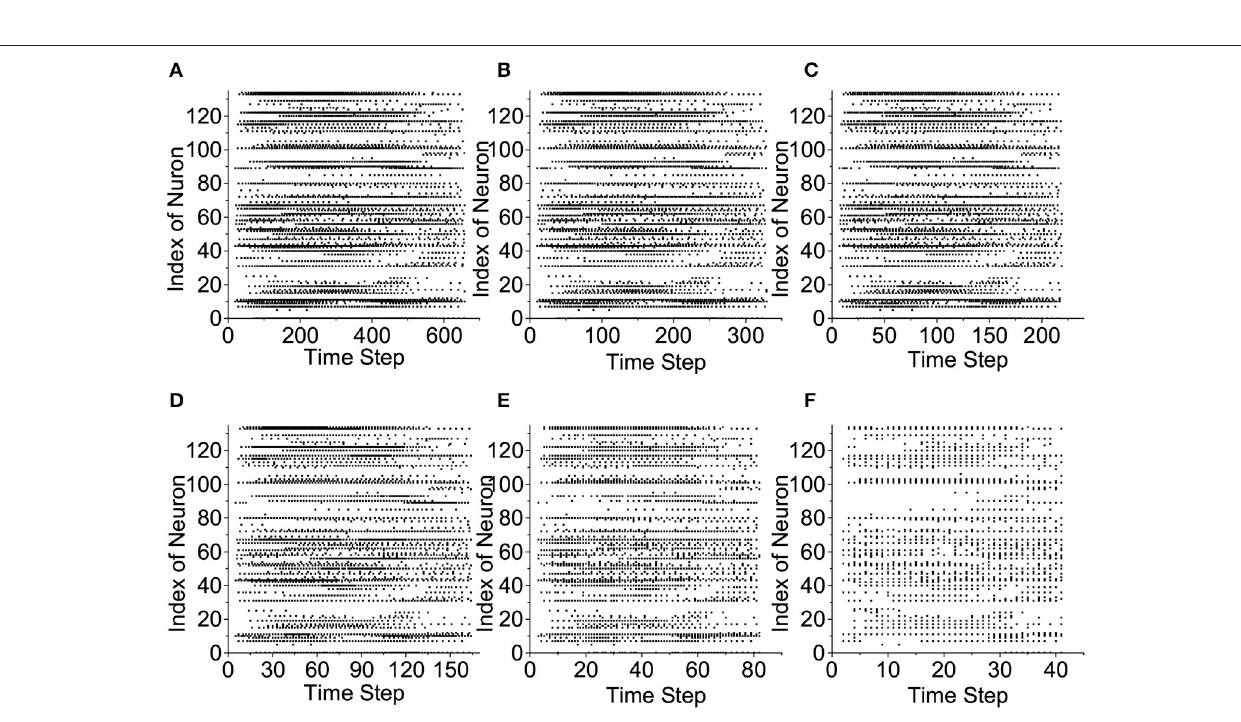
Frontiers in Neuroscience |